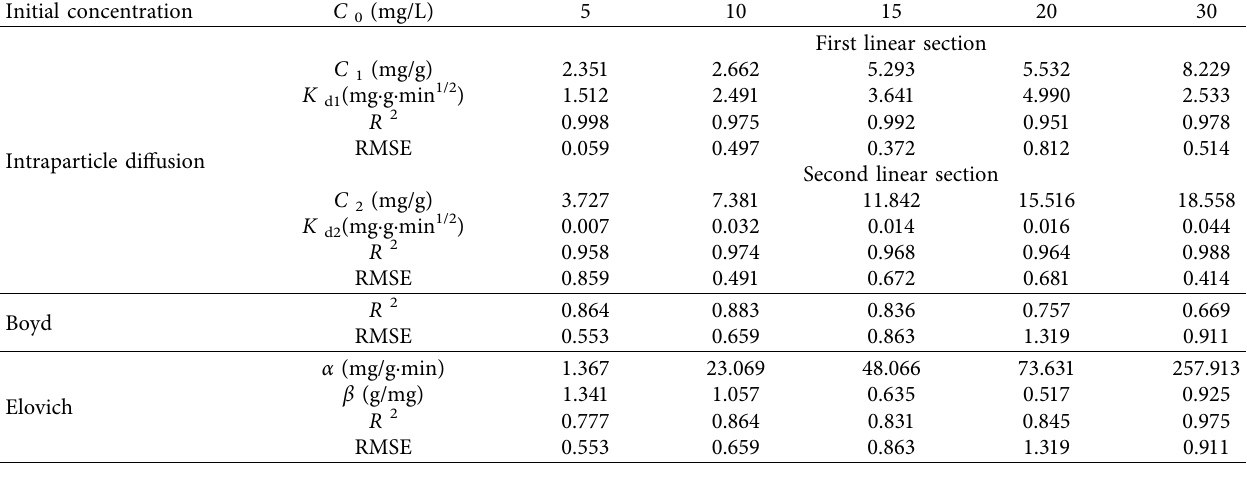
Table 5: Kinetic parameters of intraparticle diffusion, Boyd, and Elovich models for the MB@PANI-EB